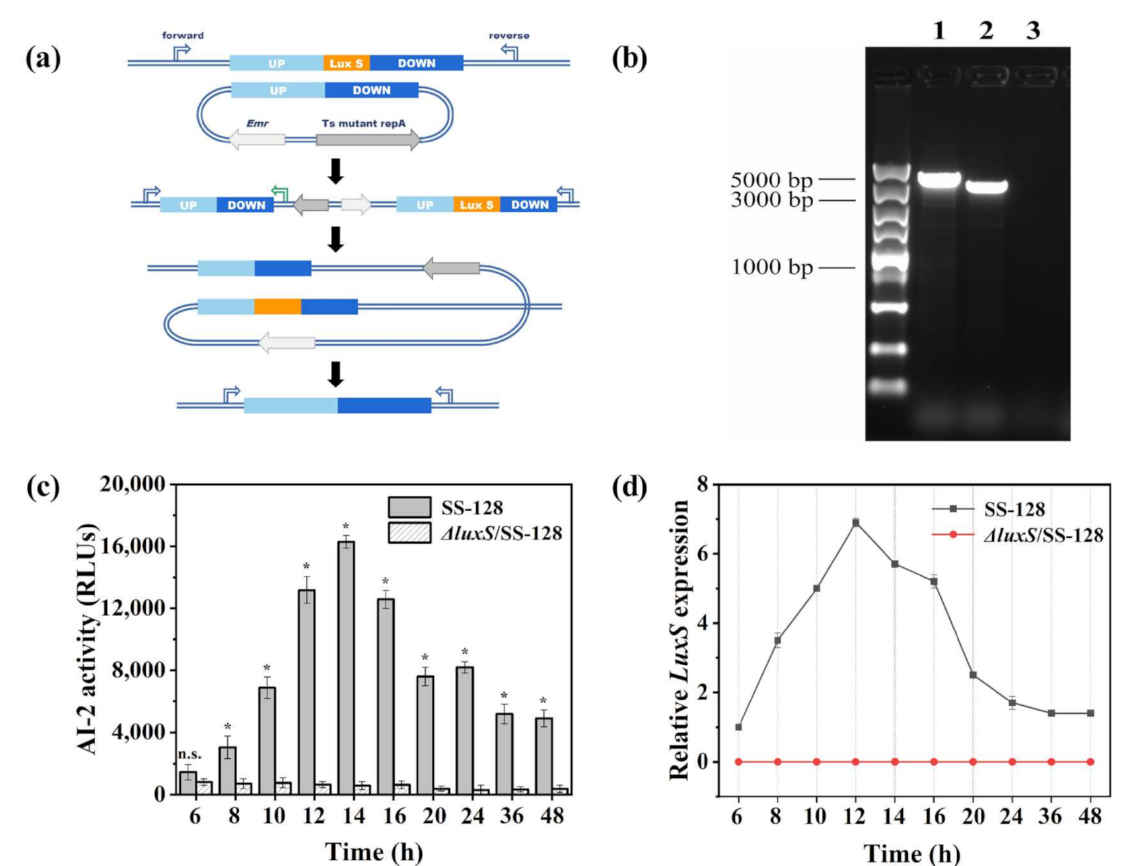
Figure 1. Two-step homologous recombination ( a ), PCR amplification ( b ), AI-2 activity ( c ), and transcription of the luxS gene ( d ) in SS-128 and ∆ luxS /SS-128. All data points mean ± standard deviations ( n = 3) with * denoting statistically significant differences ( p <